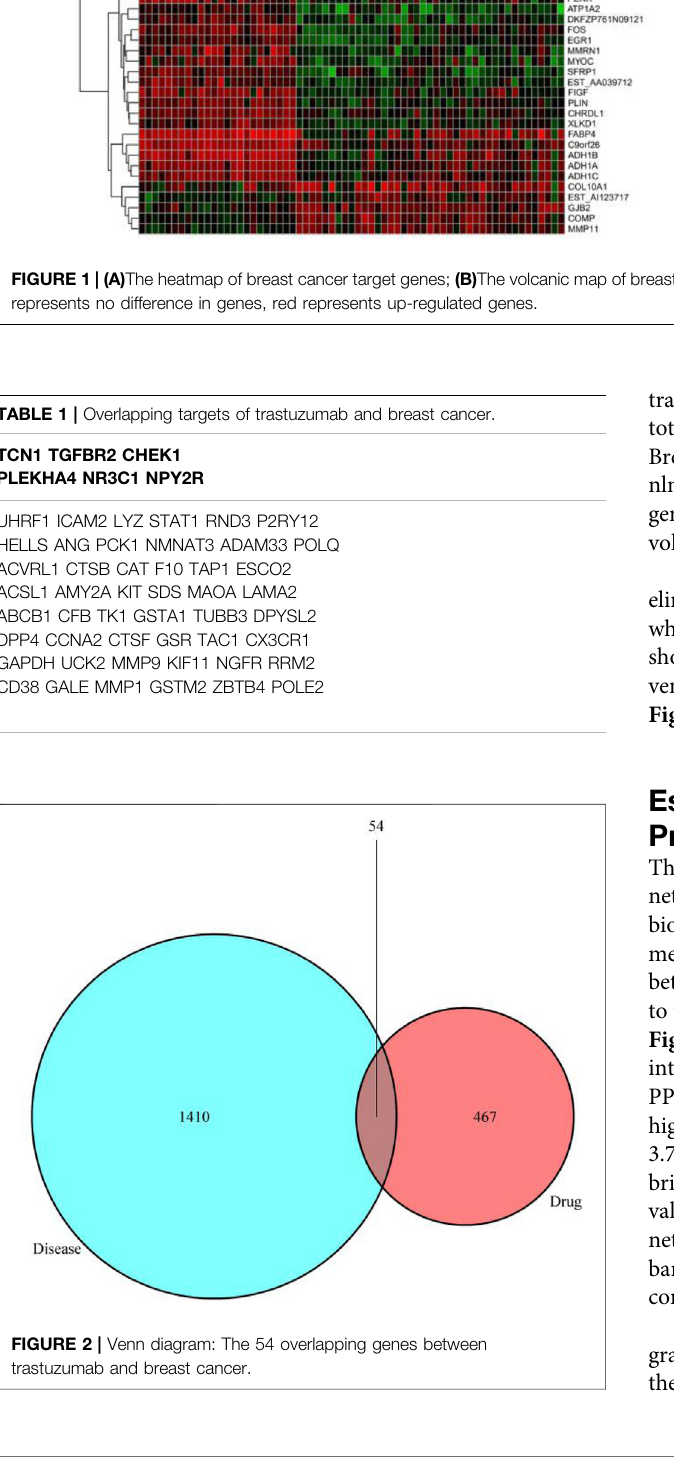
Frontiers in Physiology |